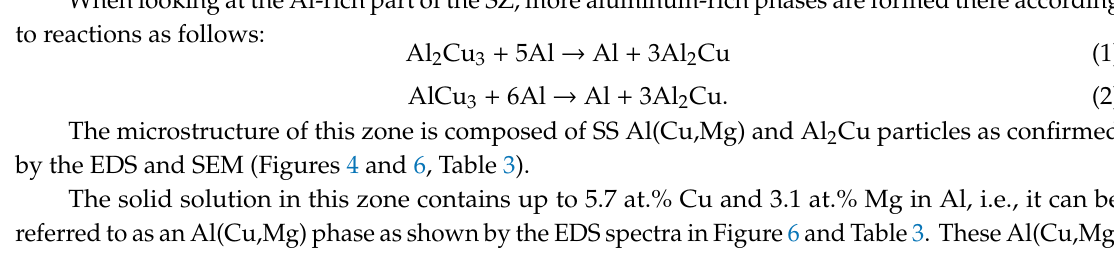
Figure 6. The SEM BSE images of microstructures in the SZ ( a , b ), which contain SS Al(Cu,Mg), Al 2 Cu and Al 2 MgCu particles as detected using the EDS probe on microstructure components denoted 1, 2, 3, 4. Table 3. Chemical compositions of phases shown in Figure 6.